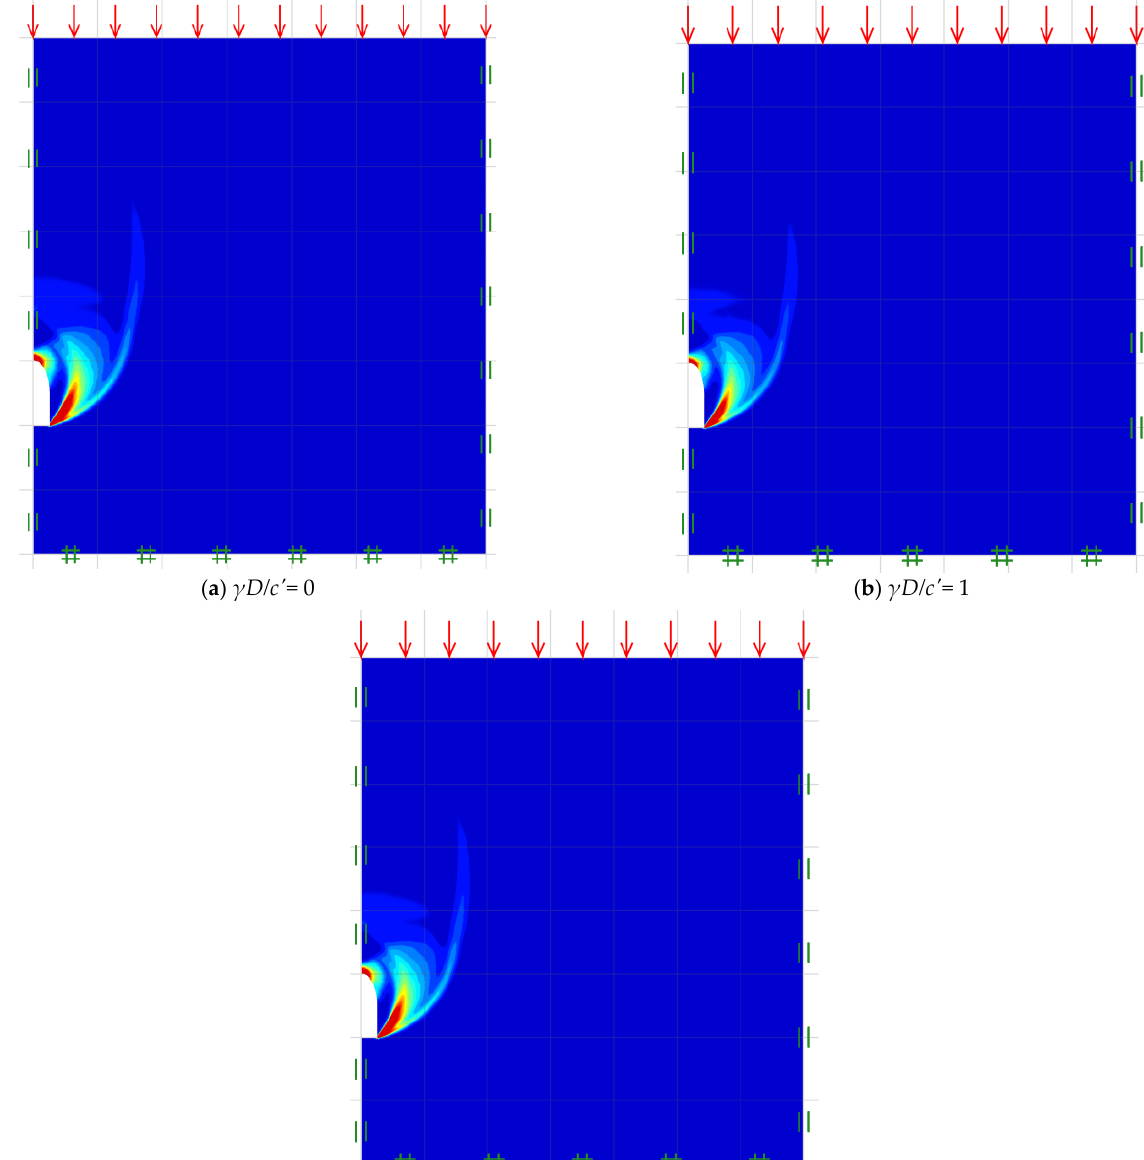
Figure 10. Shear dissipations for various γ D/ c' ( C/D = 5, B/D = 0.5 and ϕ = 20°).